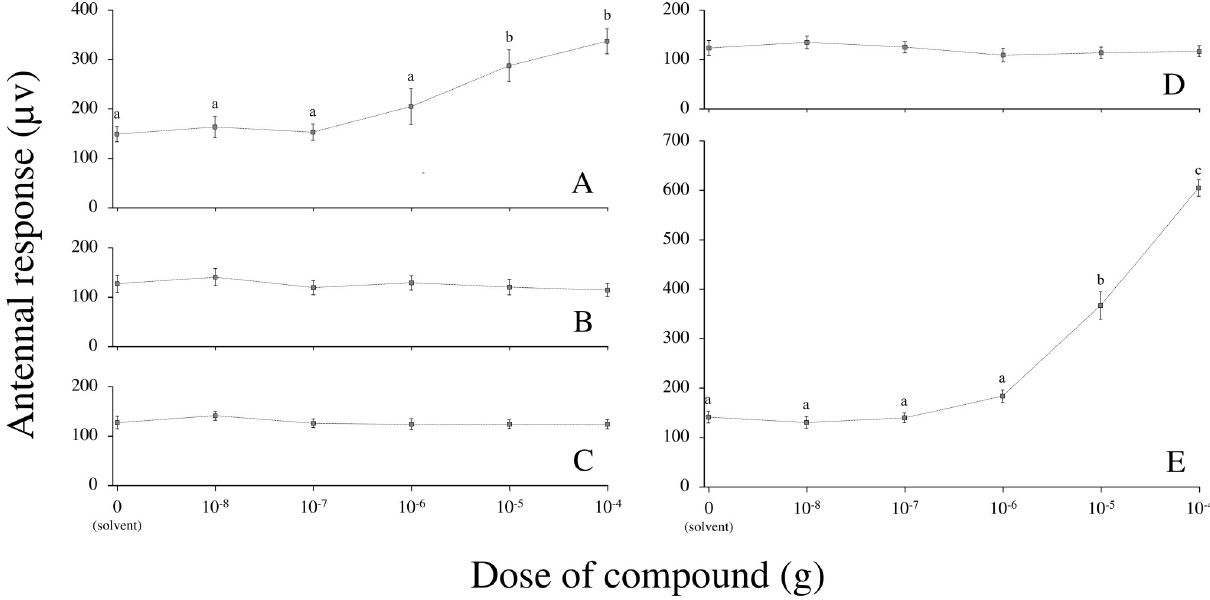
Fig 4. Antennal dose-responses of engorged Aedes aegypti females towards the four carboxylic acids and the positive control at 5 different doses, from 10 − 8 to 10 − 4 g following a log 10 increase (mean ± S.E.M.). A : Isovaleric acid (n = 6). B : Myristoleic acid (n = 5). C : Myristic (= tetradecanoic) acid (n = 5). D : Pentadecanoic acid (n = 5). E : 1-octen-3-ol (positive control, n = 7). Different lowercase letters indicate significant differences in perception between doses within a compound (Tukey’s post-hoc: P < 0.05).